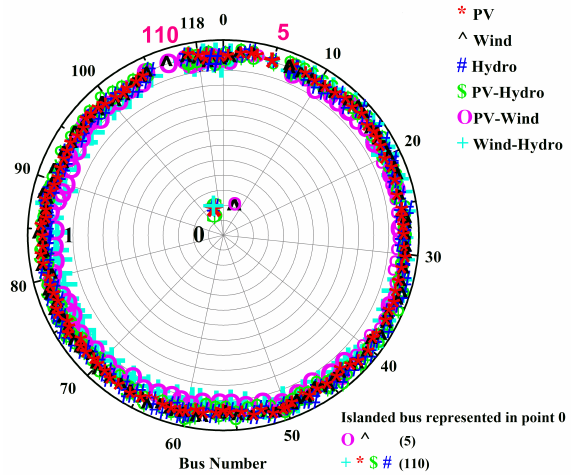
Figure 6. Voltage and frequency values. ( a ) Values (Voltage)-118 bus system. ( b ) Values (Frequency)- 118 bus system.